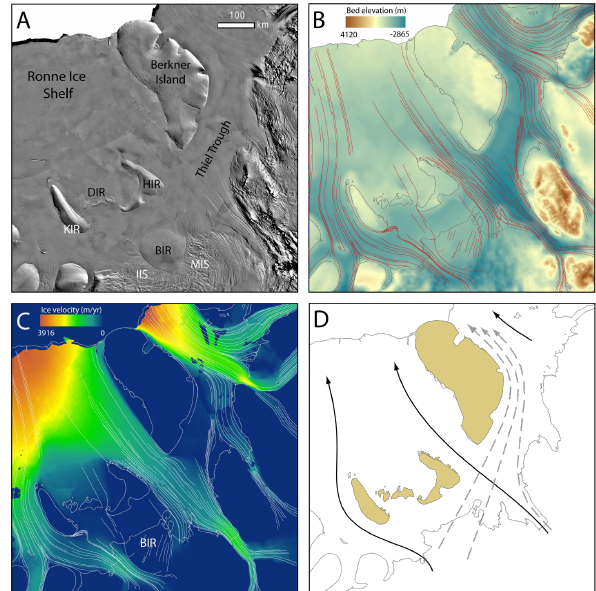
Figure 7. Maps of the Ronne Ice Shelf–Thiel Trough area. (a) Ice sheet/ice shelf surface from MOA. HIR: Henry Ice Rise; DIR: Doake Ice Rumples; KIR: Korff Ice Rise; BIR: Bungenstock Ice Rise; IIS: Institute Ice Stream; MIS: Möller Ice Stream. (b) Longitu- dinal ice-surface structures superimposed on BEDMAP-2 (Fretwell et al., 2013). Note how the flowlines follow the topography every- where other than the Thiel Trough. (c) Surface flowlines superim- posed on velocities from the MEASURES project (Rignot et al., 2011) showing good match between the two in all locations other than the Thiel Trough and its upstream continuation at the Bun- genstock Ice Rise. (d) Inferred sequence of events, with initial flow through the Thiel Trough (dashed lines and arrows) followed by a switch of flow towards the Ronne Ice Shelf under contemporary conditions (solid lines and arrows).